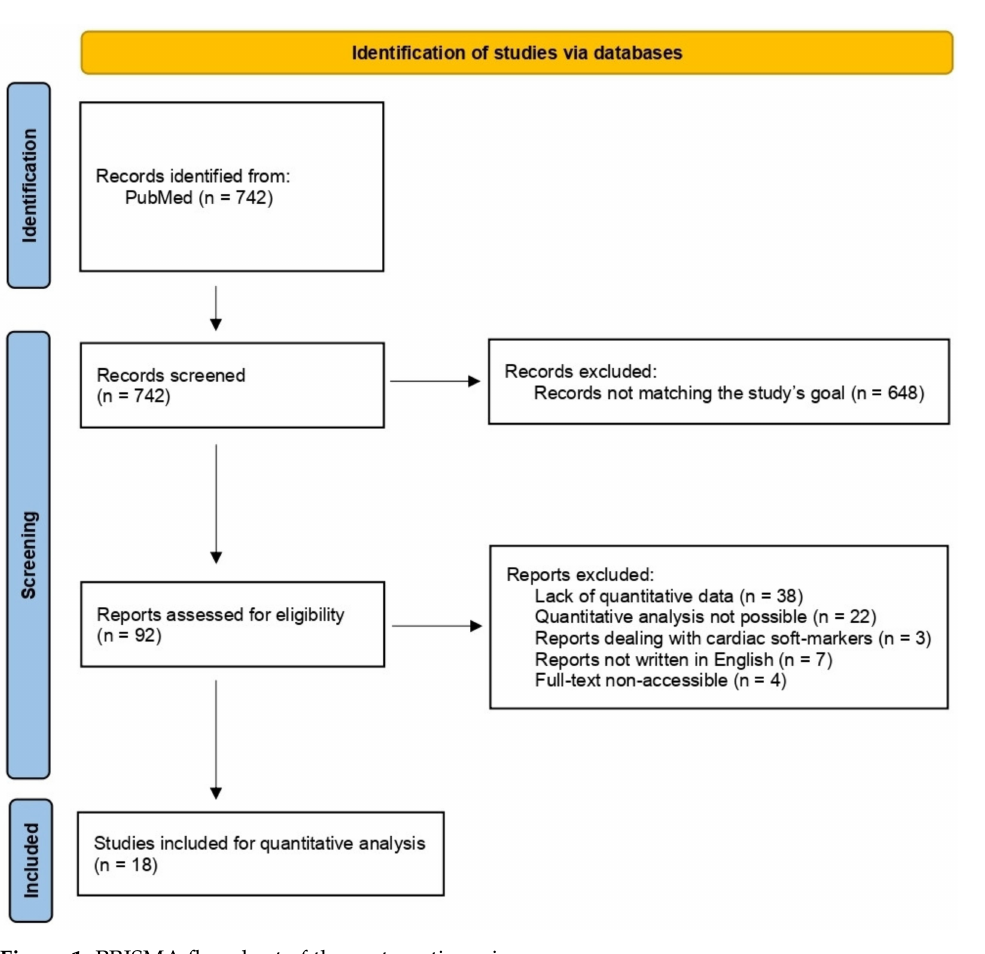
Figure 1. PRISMA flowchart of the systematic